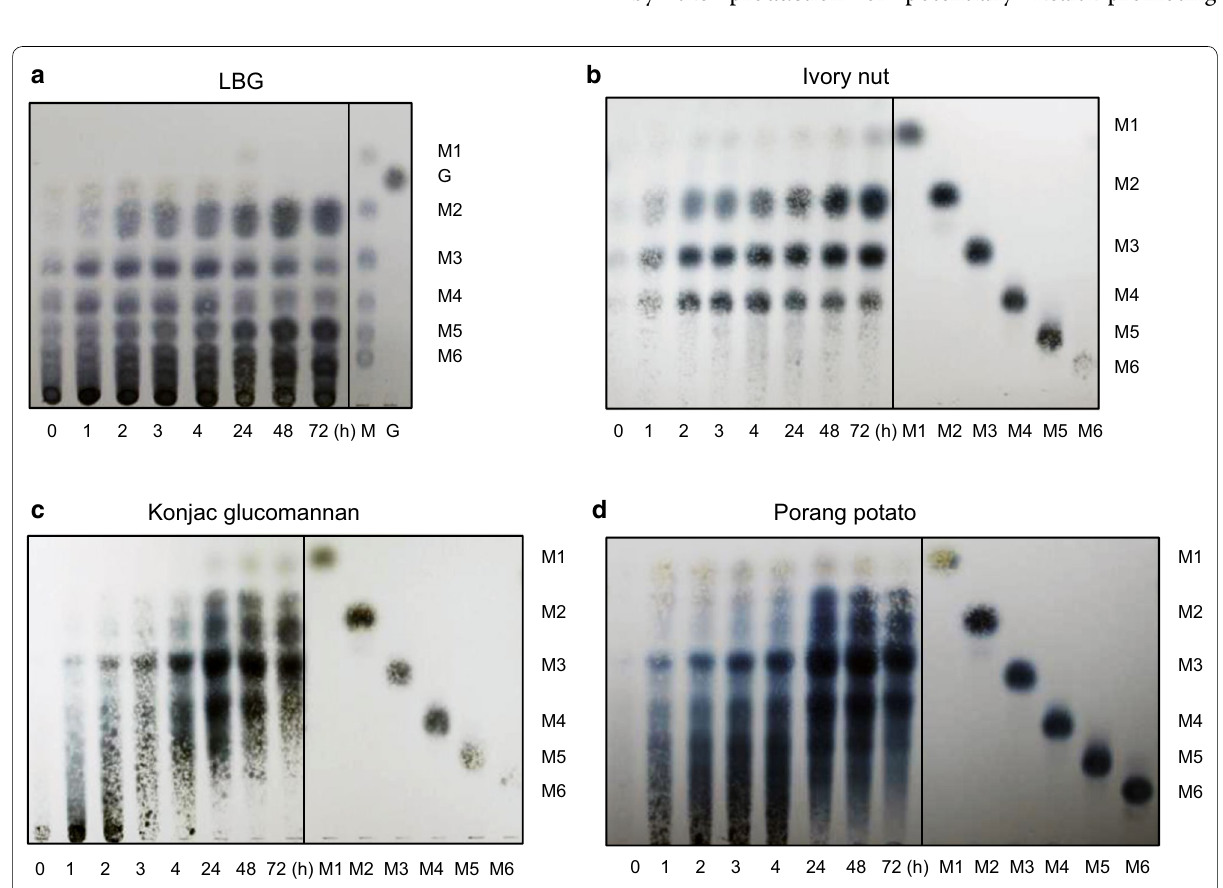
Fig. 5 TLC analysis of ManKs_4‑555 hydrolysis products from various mannan substrates, a LBG, b ivory nut, c konjac glucomannanan, and d porang potato. Standards (STD), mannose (M1), mannobiose (M2), mannotriose (M3), mannotetraose (M4), mannopentaose (M5), mannohexaose (M6), and galactose